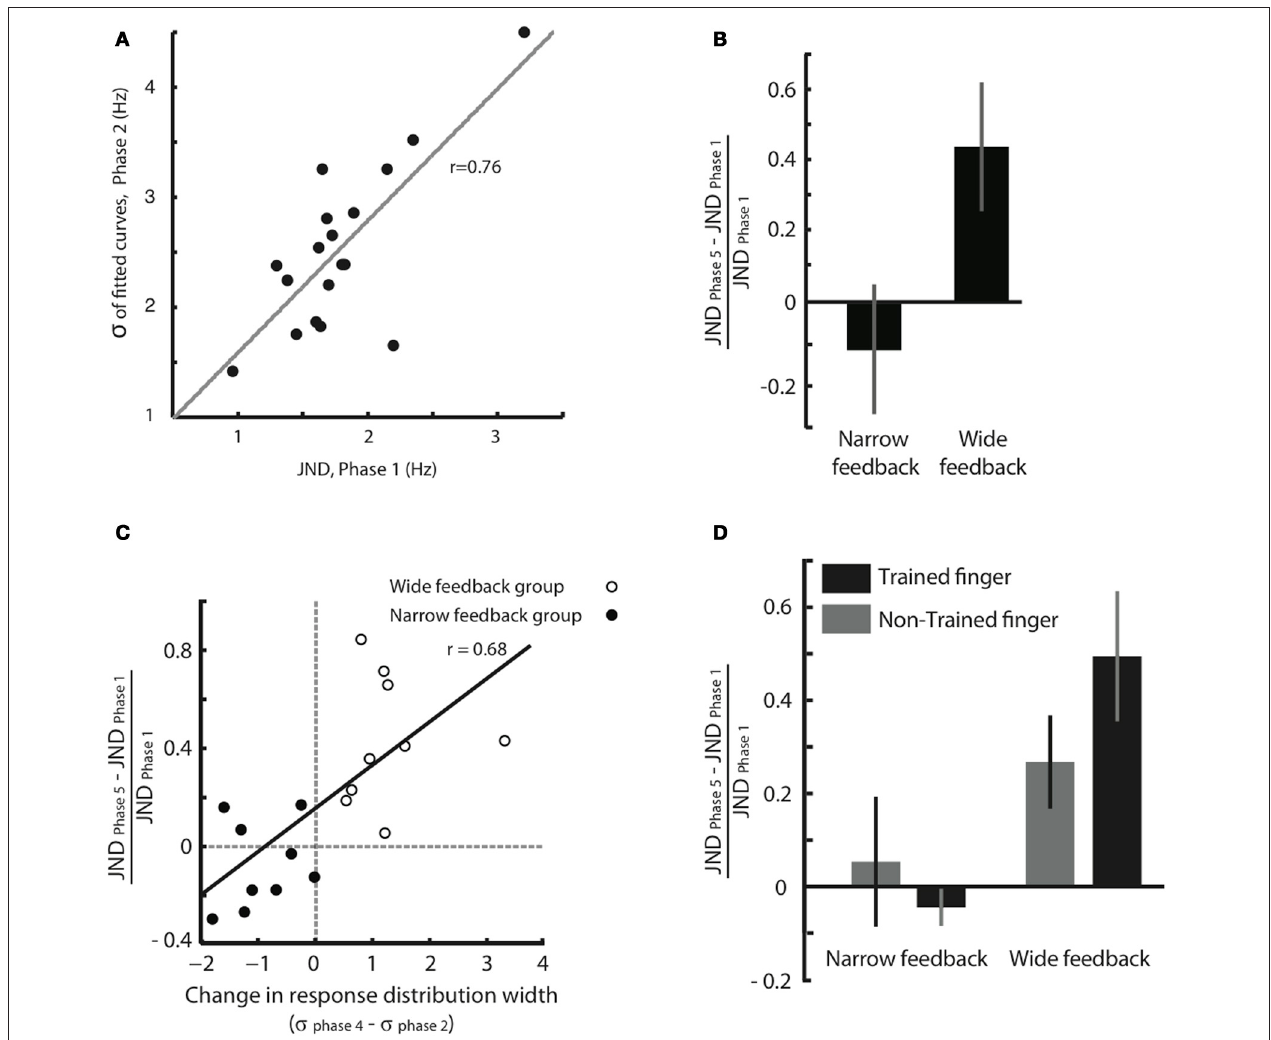
FIGURE 4 | Effect of feedback on tactile acuity. (A) Width of the response distribution in Phase 2 (quantified by the standard deviation, σ , of the fitted Gaussian curve) plotted against the JND obtained moments earlier, in Phase 1. (B) Normalized JND change (difference in each subject’s JND between Phases 5 and 1, divided by the JND of Phase 1) following training paradigm with Wide and Narrow biased feedbacks. Error bars are SEM across subjects. (C) The correlation between normalized JND change (Phase 5 compared to Phase 1) and the difference in response distribution breadth (standard deviation, σ , of the fitted Gaussian curve in Phases 4 compared to that in Phase 2). There is